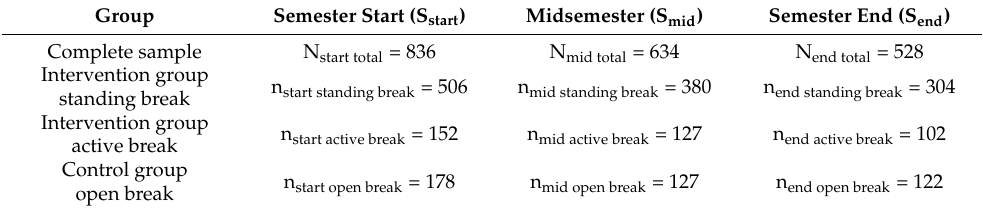
Table 3. Sample sizes by study